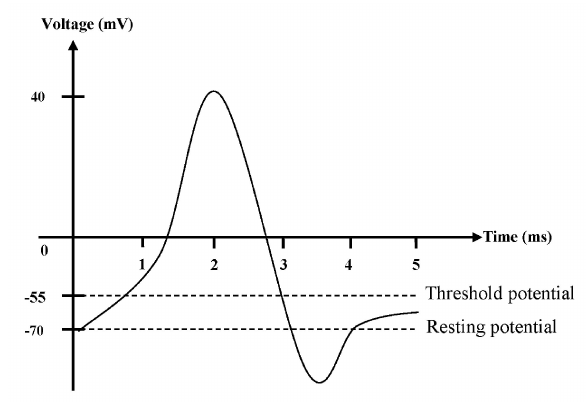
Figure 2. The action potential in